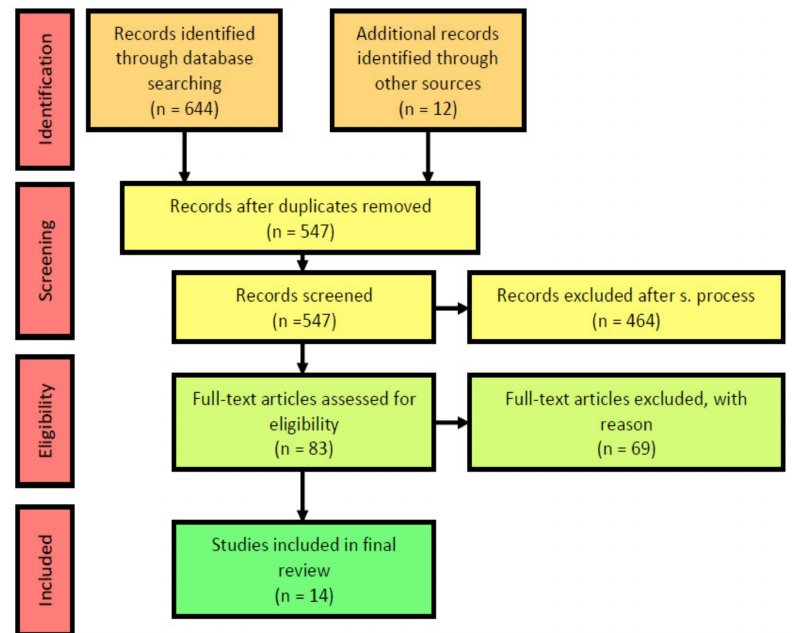
Figure 1. PRISMA flow